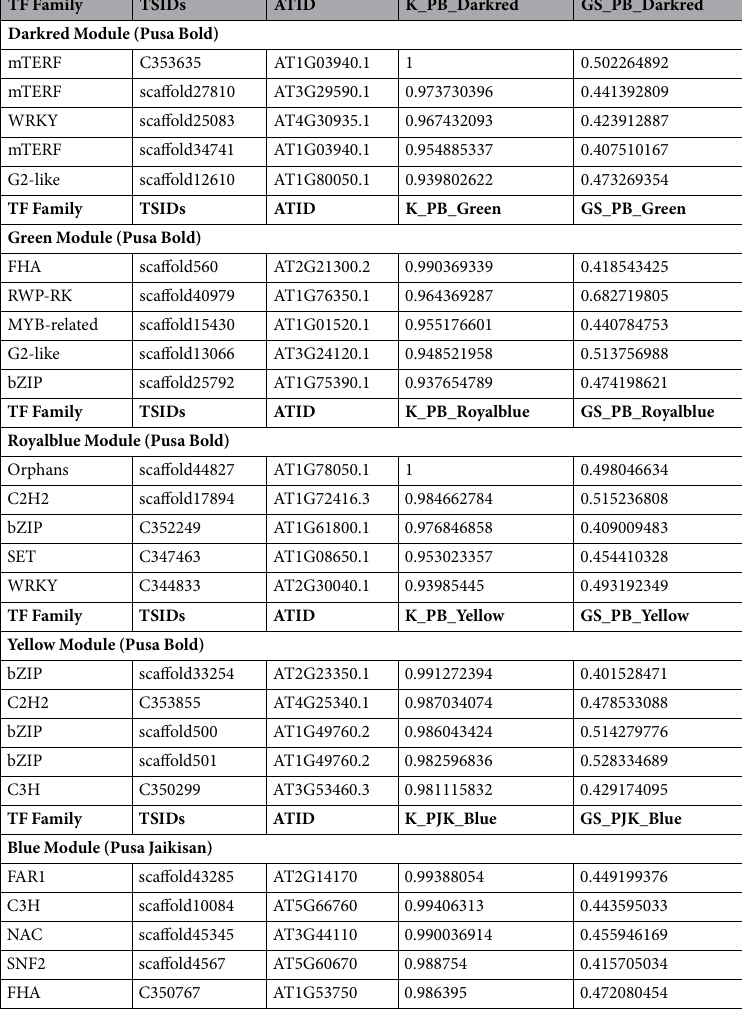
Table 3. Top-5 HUB TFs identified in nitrate responsive modules of B . juncea cv. Pusa Bold and Pusa Jaikisan. Each module with top-5 TFs, their transcript sequence ID (TSID), ATID (Arabidopsis TAIR ID names), K (Scaled connectivity), GS (Gene significance) are shown in